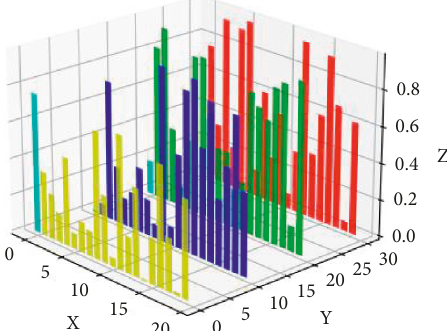
Figure 10: Accuracy comparison of multiple methods.